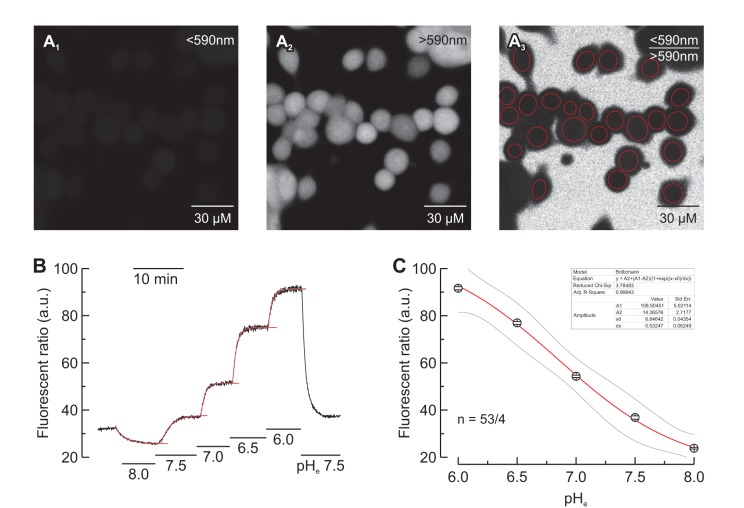
Calibration of SNARF-5 in MCF-7 cells.(A) Confocal images of MCF-7 cells, loaded with SNARF-5. (A1) Signal of the emission fraction below 590 nm. (A2) Signal of the emission fraction above 590 nm. (A3) Signal of the emission fraction below 590 nm divided by the signal of the emission fraction above 590 nm. (B) Calibration of the fluorescence ratio in the presence of nigericin and 130 mM K+, at pH 8.0, 7.5, 7.0, 6.5 and 6.0. An exponential equation was used to calculate the maximum steady state for each pH application, as indicated by the red traces. Gray traces indicate the confidence bands (at the 95% confidence level). (C) Fluorescent ratio plotted against the extracellular pH (mean ± SEM). A Boltzmann fit (red) was used to calculate the parameters of conversion (inset). Gray traces indicate the confidence bands (at the 95% confidence level). pH values are calculated as pH=x0+dx*ln⁡A1-A2R-A2-1.